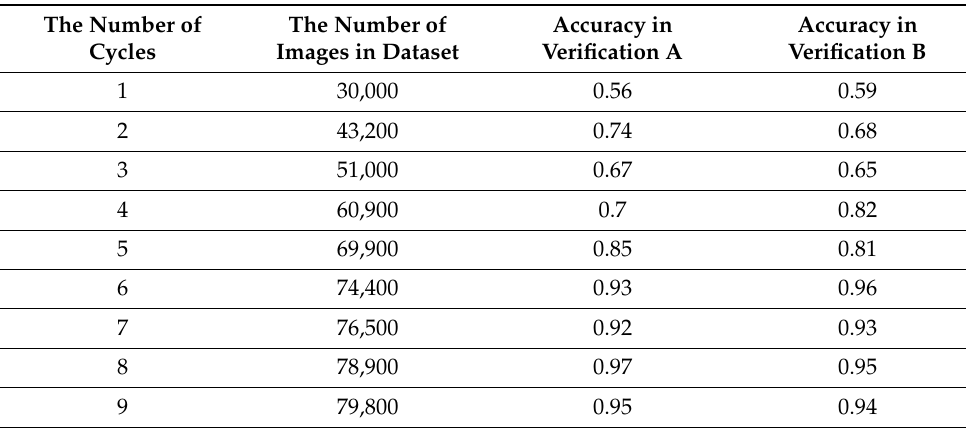
Figure 6. Flow chart for efficient data increase. Table 2. Training process and improvement of